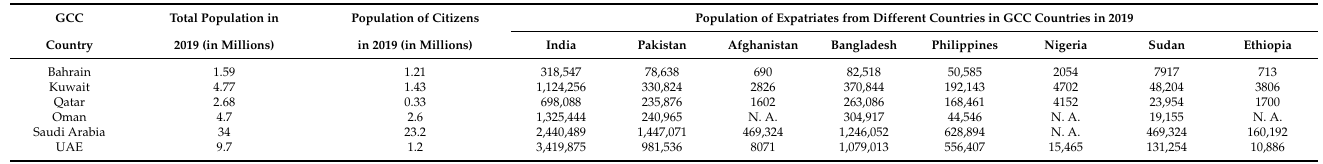
Table 3. Number of local citizens and expatriate population (originating from malaria-endemic countries) among the GCC countries.